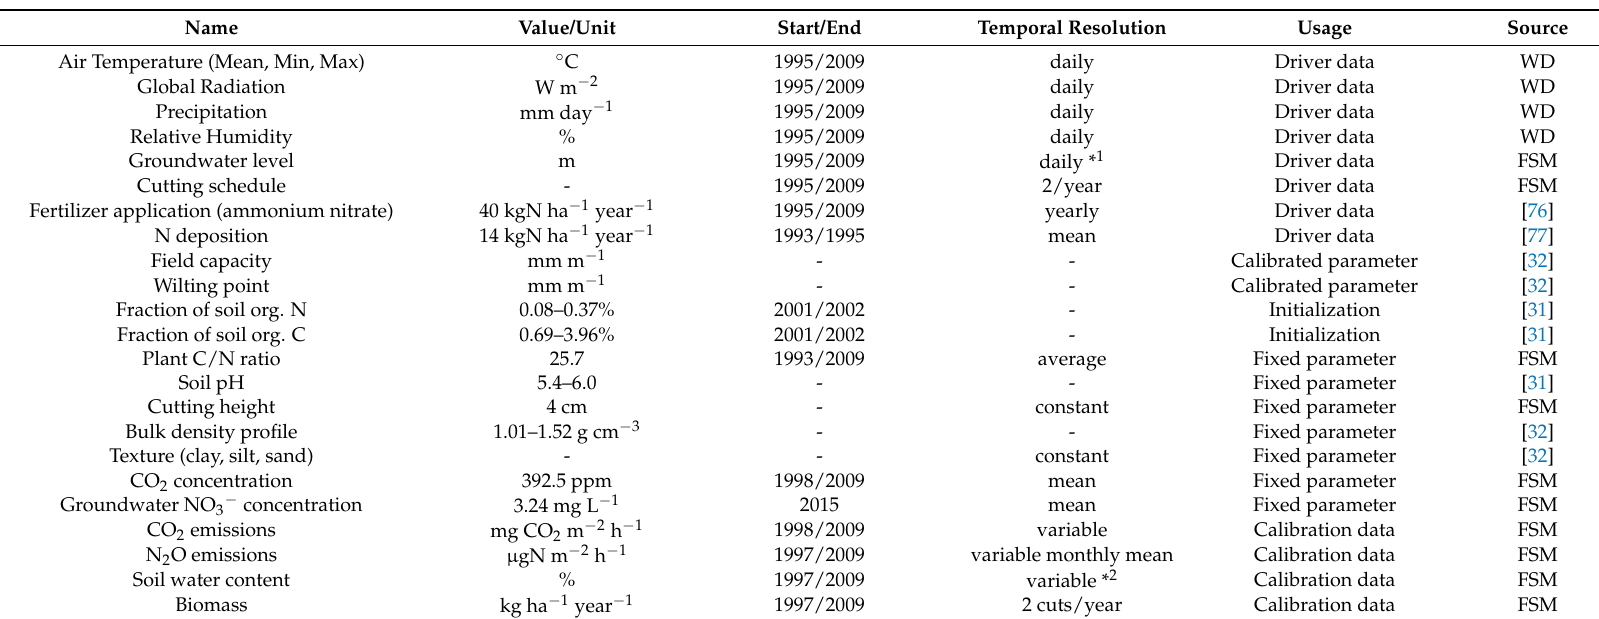
Table A1. Measured data implemented in LandscapeDNDC: FSM = field site measurements (see Section 2.1); WD = weather data [75]; variable = soil moisture, CO 2 and N 2 O emissions measurements ranged from several per week to several per